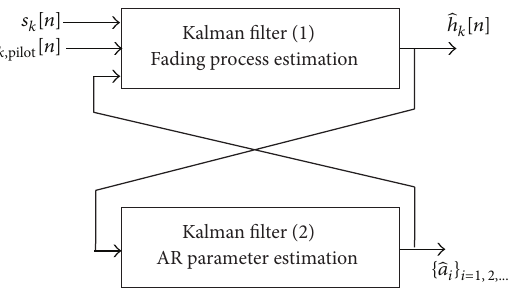
Figure 4: Dual Kalman filters based structure for the joint esti- mation of the fading process and its AR parameters over the 𝑛 th FBMC/OQAM